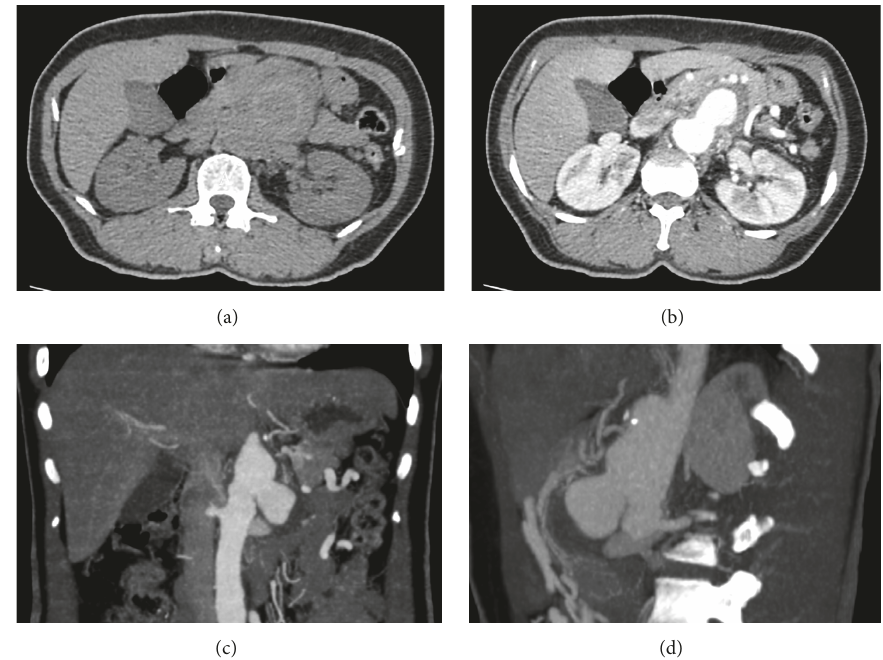
Figure 1: Crescent sign of suprarenal aortic aneurysm (a). A-phase shows saccular aneurysm behind the pancreas (b). Coronal view: suprarenal saccular aneurysm mainly on the left side (c). Sagittal view: aneurysm bulge anteriorly displacing the pancreas (d).